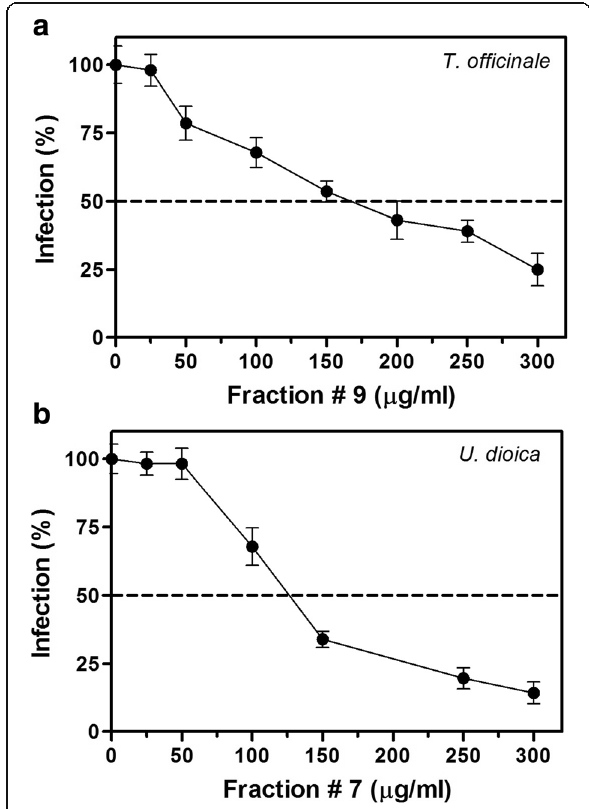
Fig. 3 Antiviral activity of fractions 7 and 9 of T. officinale ( a ) and U. dioica ( b ) extracts obtained by silica gel chromatography